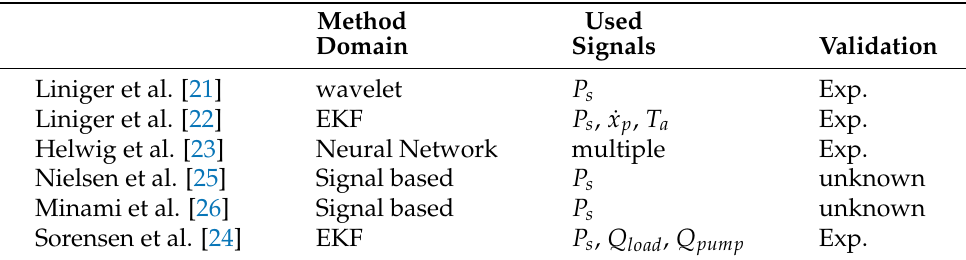
Table 2. Covered fault detection methods for accumulator gas leakage. The notations of the used signals can be found in Figure